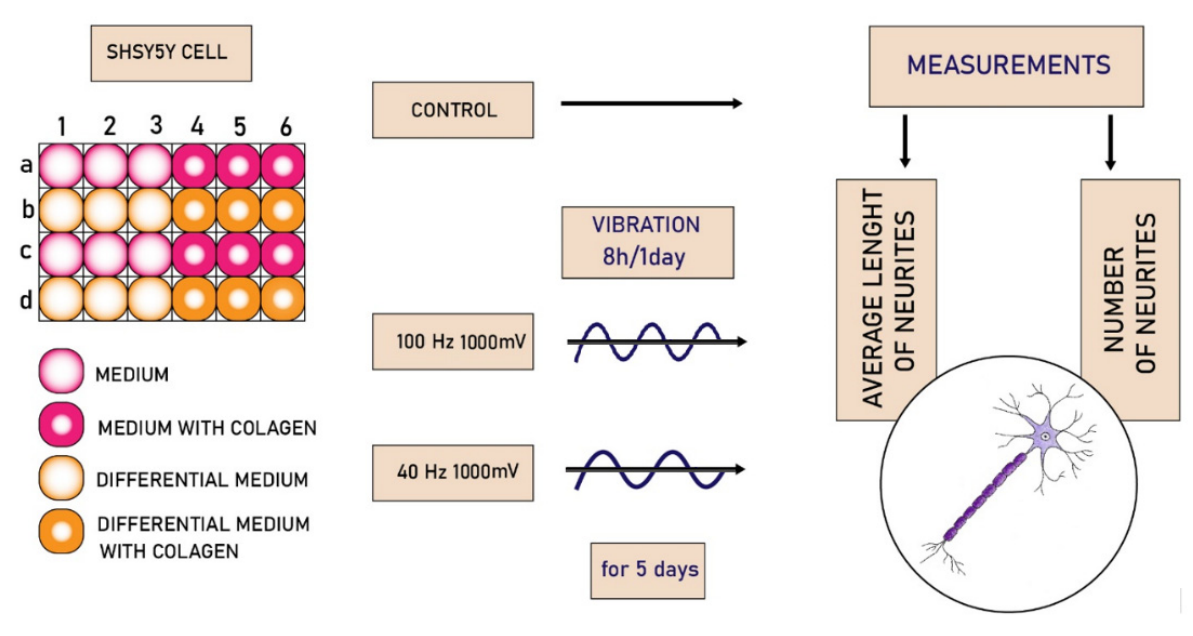
Figure 6. Block diagram of the medical experiment carried out.